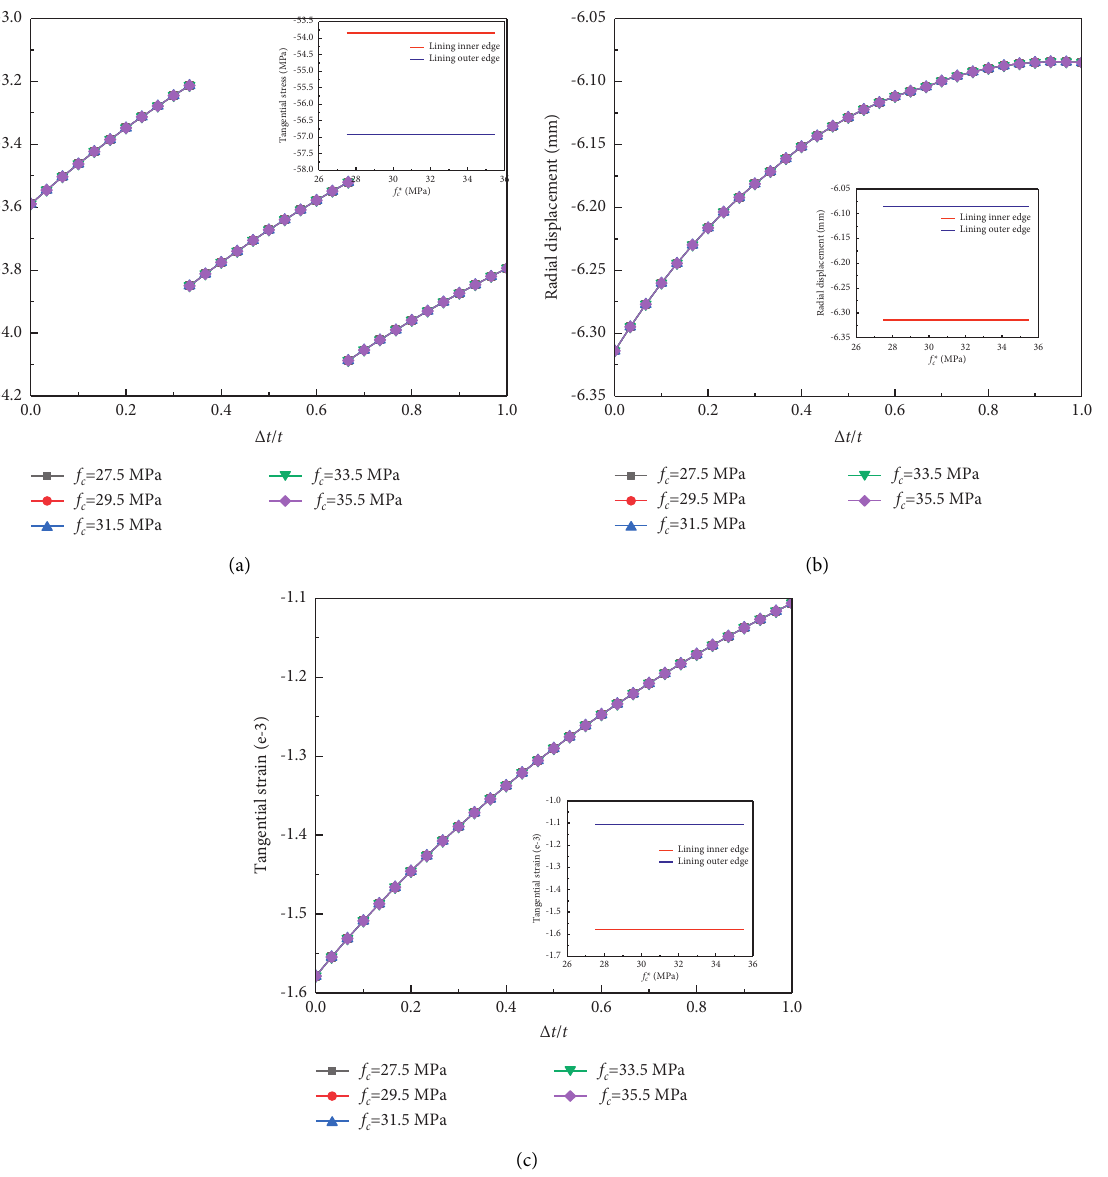
Figure 6: Variations in tangential stress, radial displacement, and tangential strain of FGL with concrete compressive strength f ∗ (a) Tangential stress. (b) Radial displacement. (c) Tangential